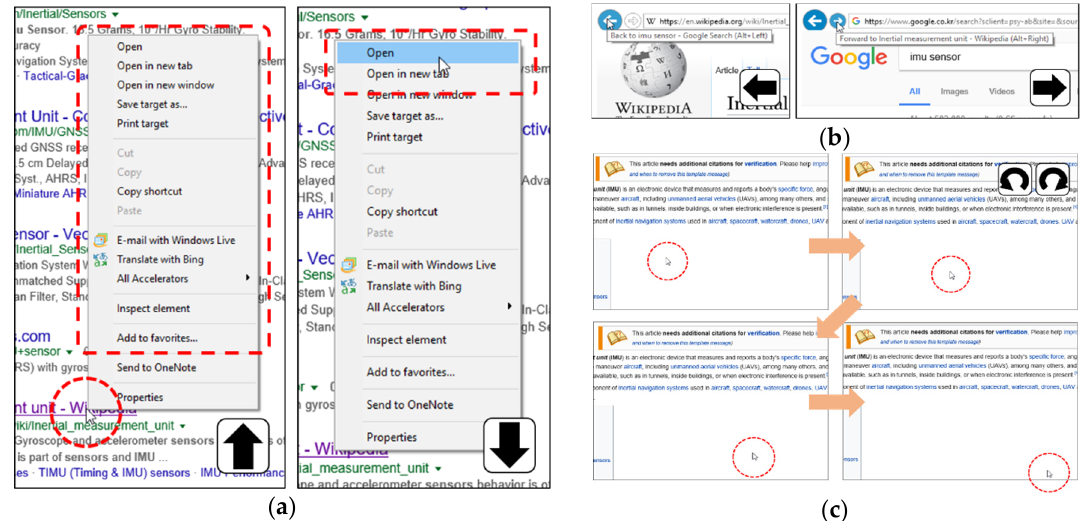
Figure 8. Practical test with web browser ( a ) left and right click, ( b ) back and forward, and ( c ) converting to the position mode.